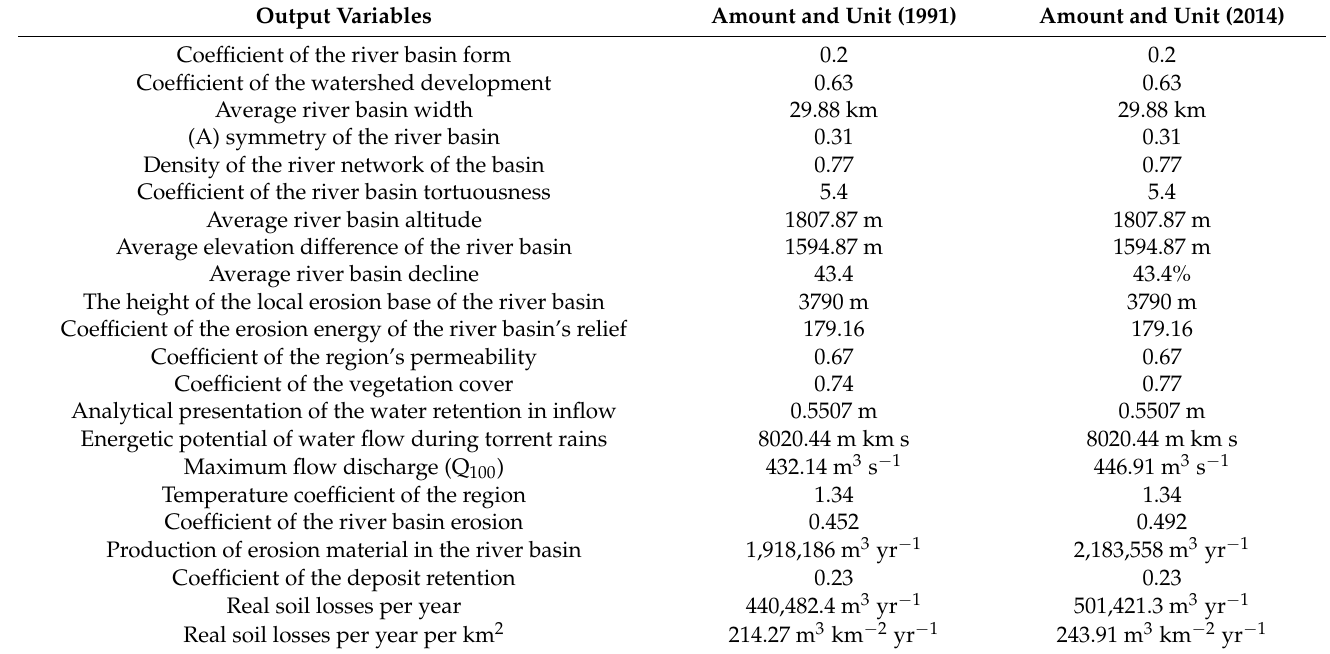
Table 6. The outputs of the IntErO for Talar